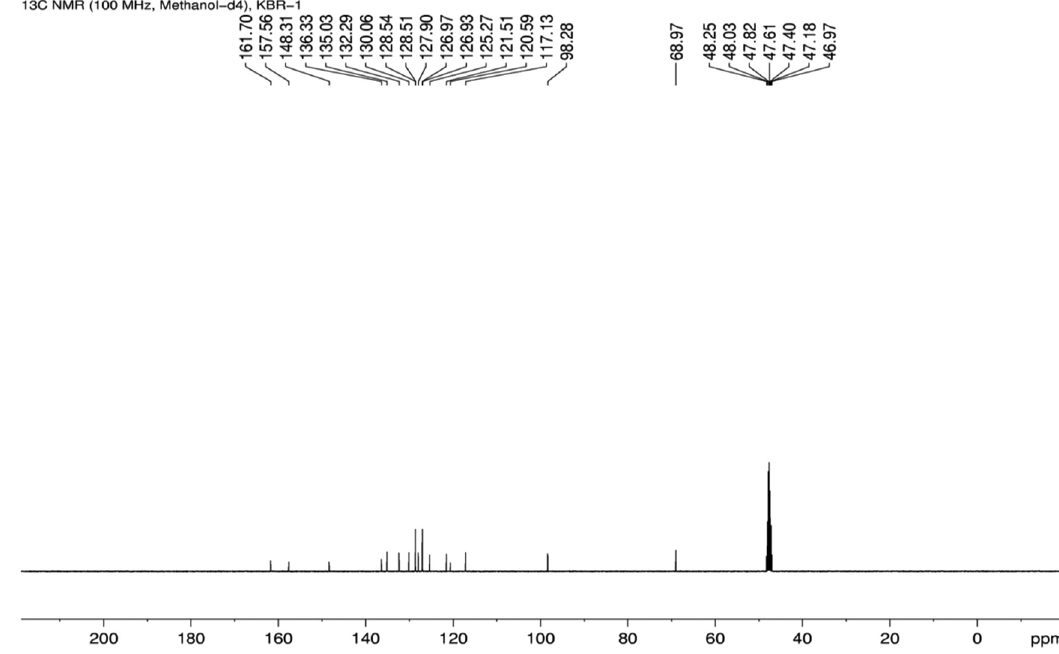
Figure 7: 13 C NMR spectrum of compound 2h in methanol - d 4